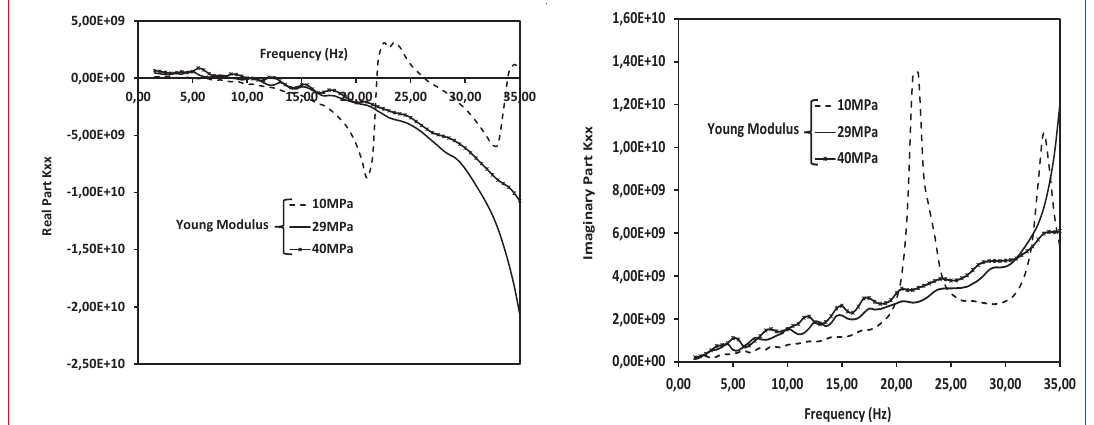
Figure 15: Influence of the Young modulus on the vertical dynamic impedance.